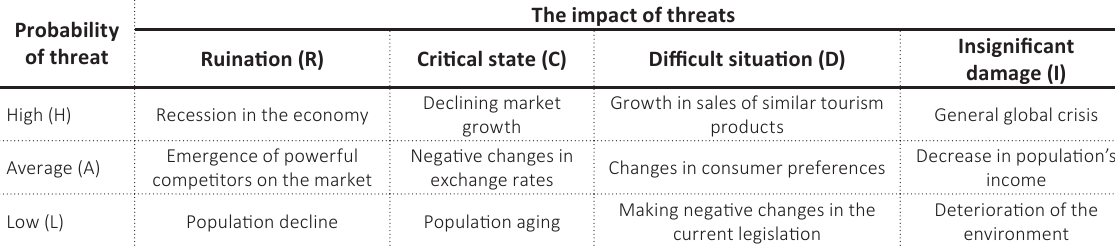
Table 9. Threats for tourism infrastructure